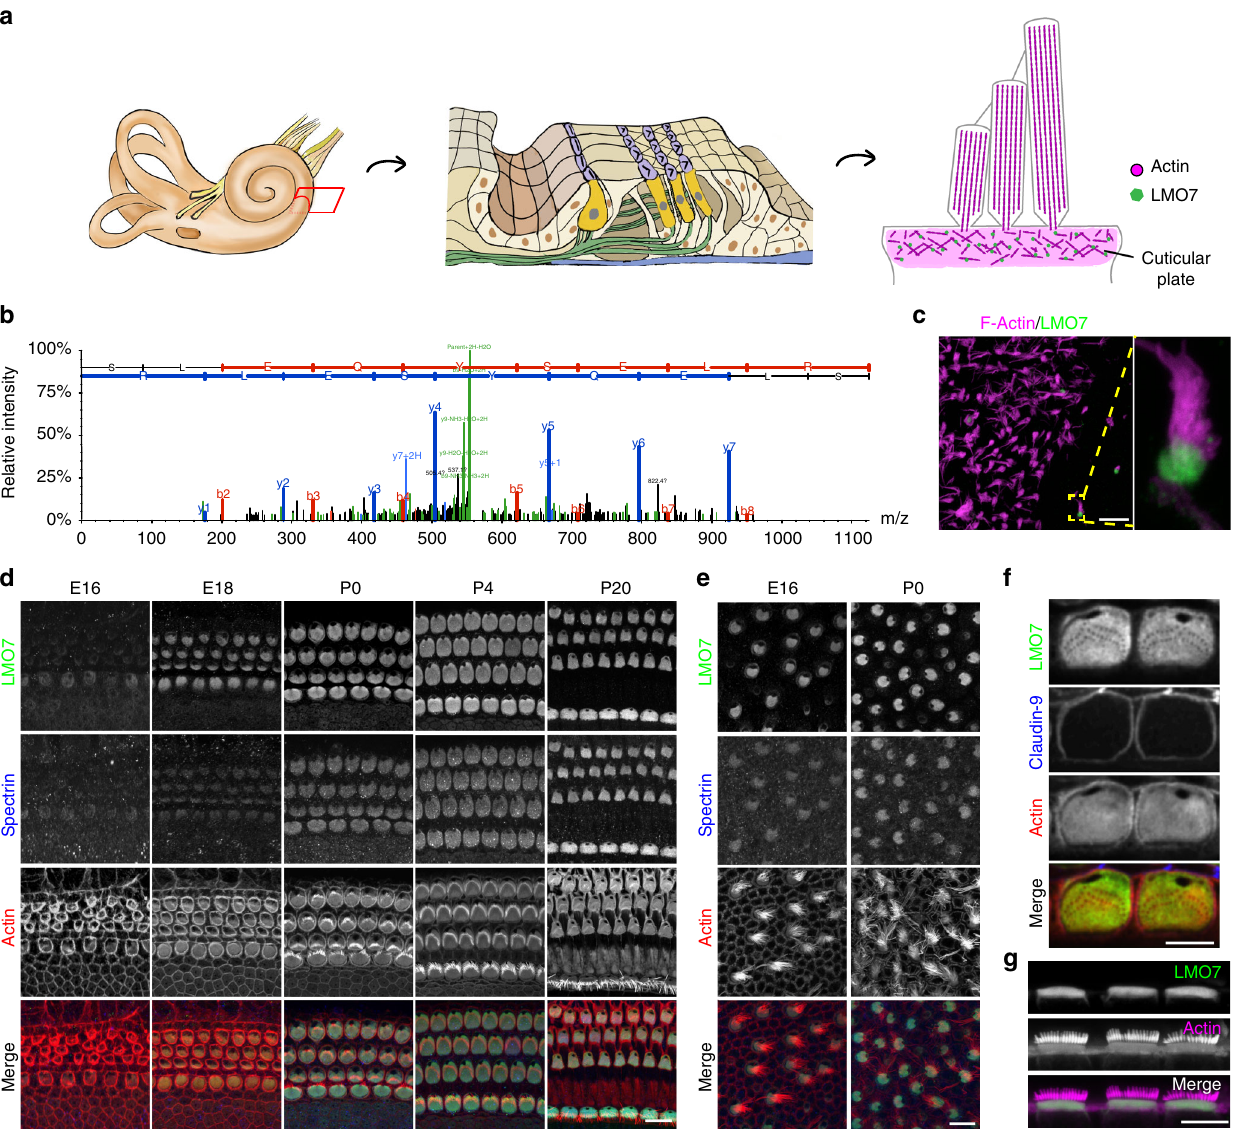
Fig. 1 LMO7 is a component of the cuticular plate and the junctions. a Schematic representation of inner ear organization and the apical structures of the hair cell. b MS/MS spectrum of a representative peptide of chick LMO7, identi fi ed by LC-MS/MS on isolated chick hair bundles. The data for the spectrum was obtained from a previously published dataset 35 . c LMO7 immunoreactivity (green) in isolated mouse hair bundles con fi rmed its presence in cuticular plate (labeled by phalloidin in magenta). Scale bars, 20 μ m (overview), 5 μ m (panel magni fi cation). d , e Immunohistochemical analysis of LMO7 expression in the mouse cochlea and utricle at various ages. LMO7 expression is detected in hair cells at E16, with the initial emergence of the hair bundle. Scale bar, 10 μ m. f Higher-magni fi cation views of LMO7 and claudin 9 immunoreactivity in mouse inner hair cells at the level of the cuticular plate. LMO7 localization is restricted to the cuticular plate and the intercellular junctions. g Side view of LMO7 expression in the inner hair cell. Scale bar, 5 μ